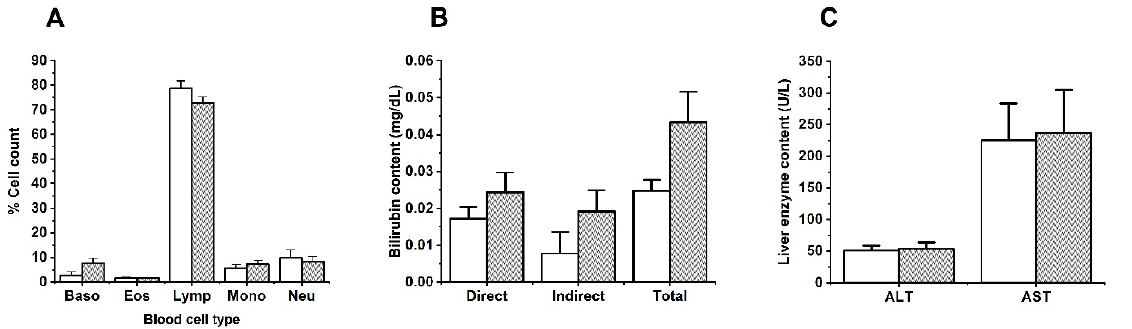
Figure 3. Effects of MIX–160 on ( A ) blood cells, ( B ) bilirubin and ( C ) AST and ALT transaminases in repeated dose 28–day oral toxicity evaluations. The control group is represented in white, and MIX–160 is represented in gray.